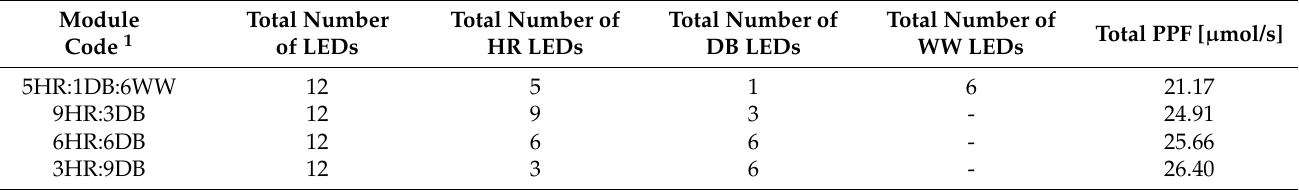
Table 1. Composition of the LED modules used in the experiments to create the light recipes considered in the experimental plan.